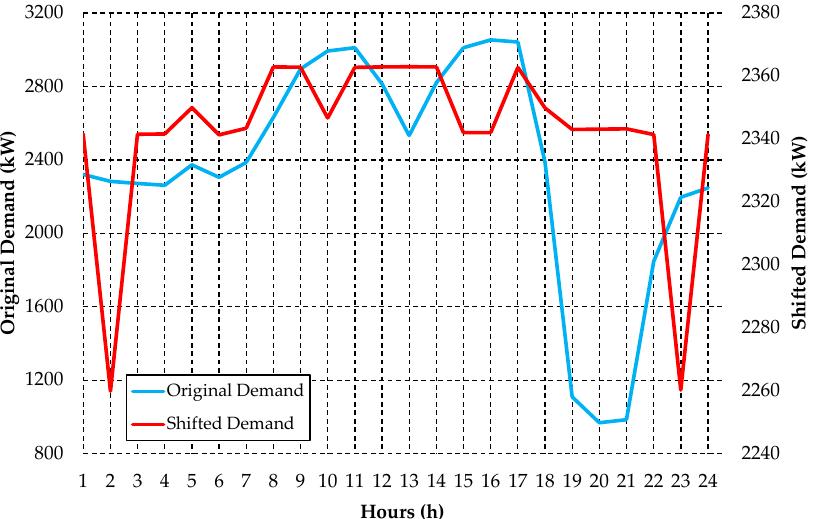
Figure 20. Comparison of the original and shifted demand profiles for Rural Feeder B.